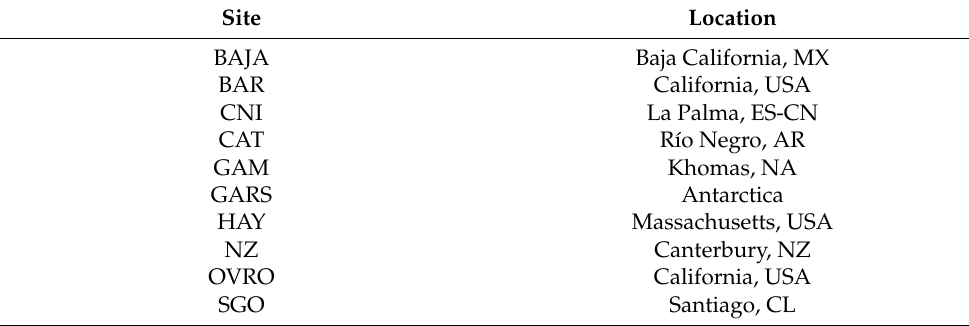
Table 2. Candidates sites used in the hypothetical ngEHT array.